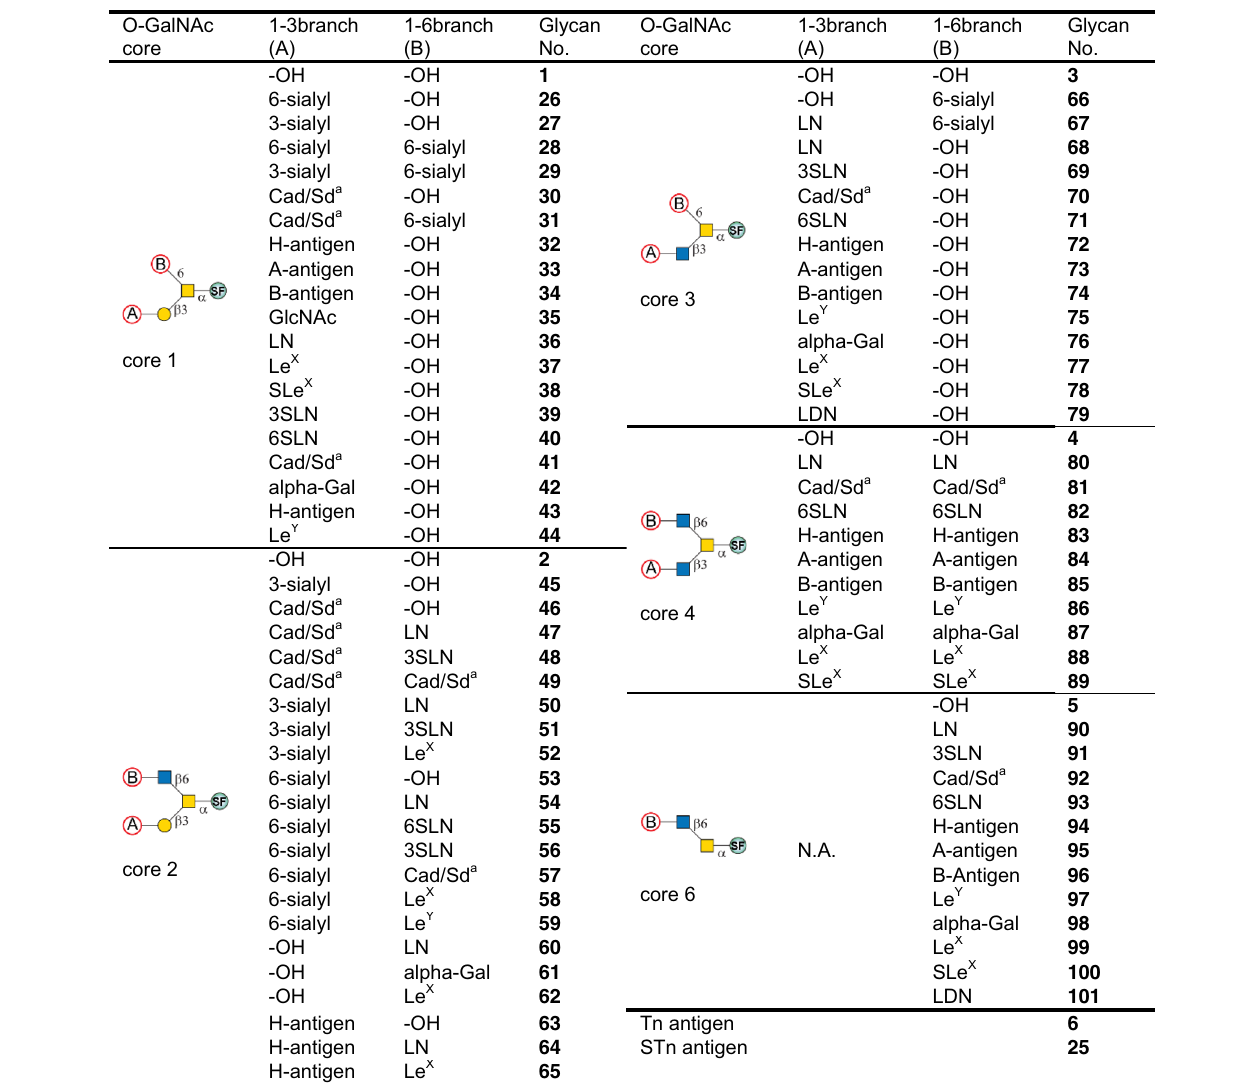
Table 1 Ser-linked O-GalNAc glycans prepared in this study. O-GalNAc